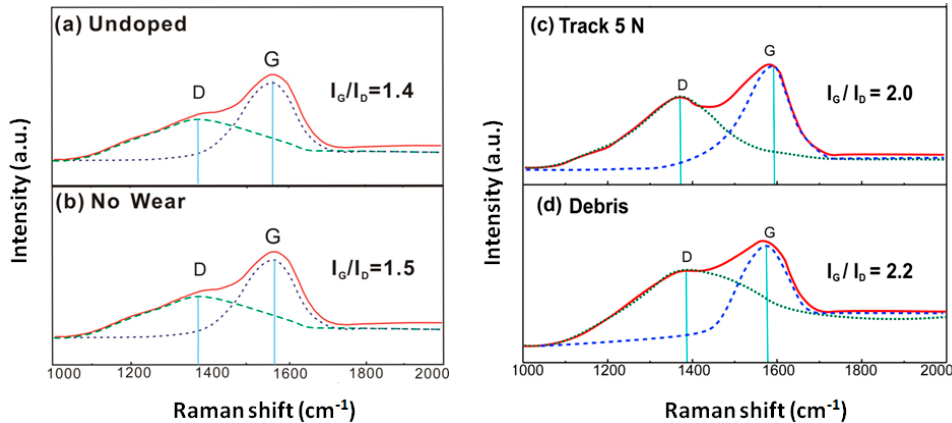
Figure 7 . Raman spectra of the undoped DLC film and a:C-Ag 10.5% film. Note: ( a ) Undoped DLC film (Undoped), left top; ( b ) as-deposited film (No wear), left bottom; ( c ) wear track at 5 N load (Track 5 N), right top; and ( d ) wear debris (Debris), right bottom.